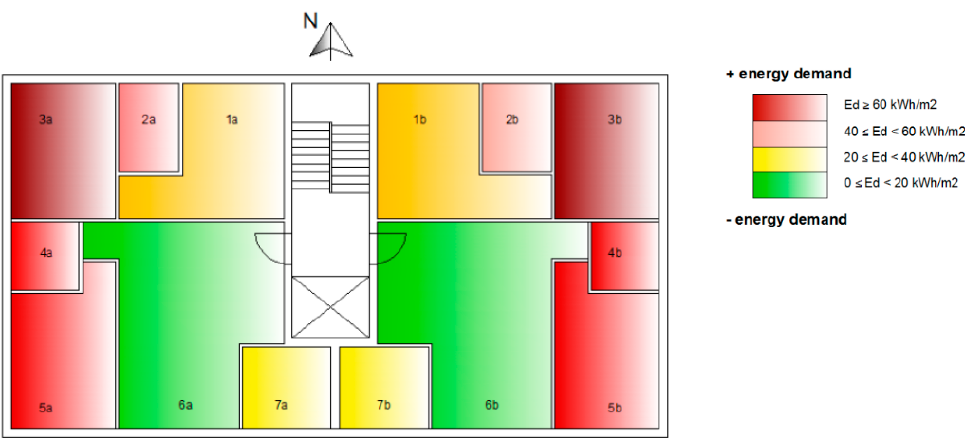
Figure 5. Colour map of the energy demand (Ed) evaluated for the “as-built” configuration.